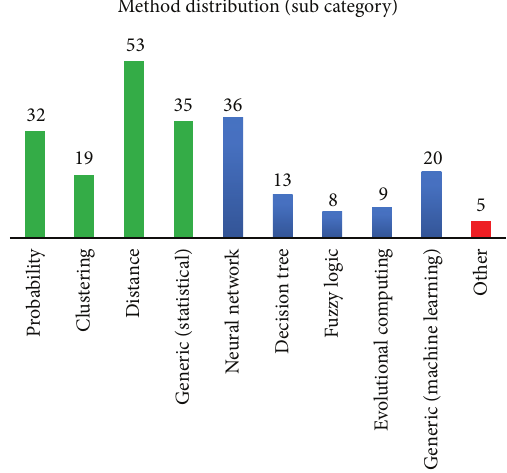
Figure 8: Percentage distribution among classification methods employed by keystroke research